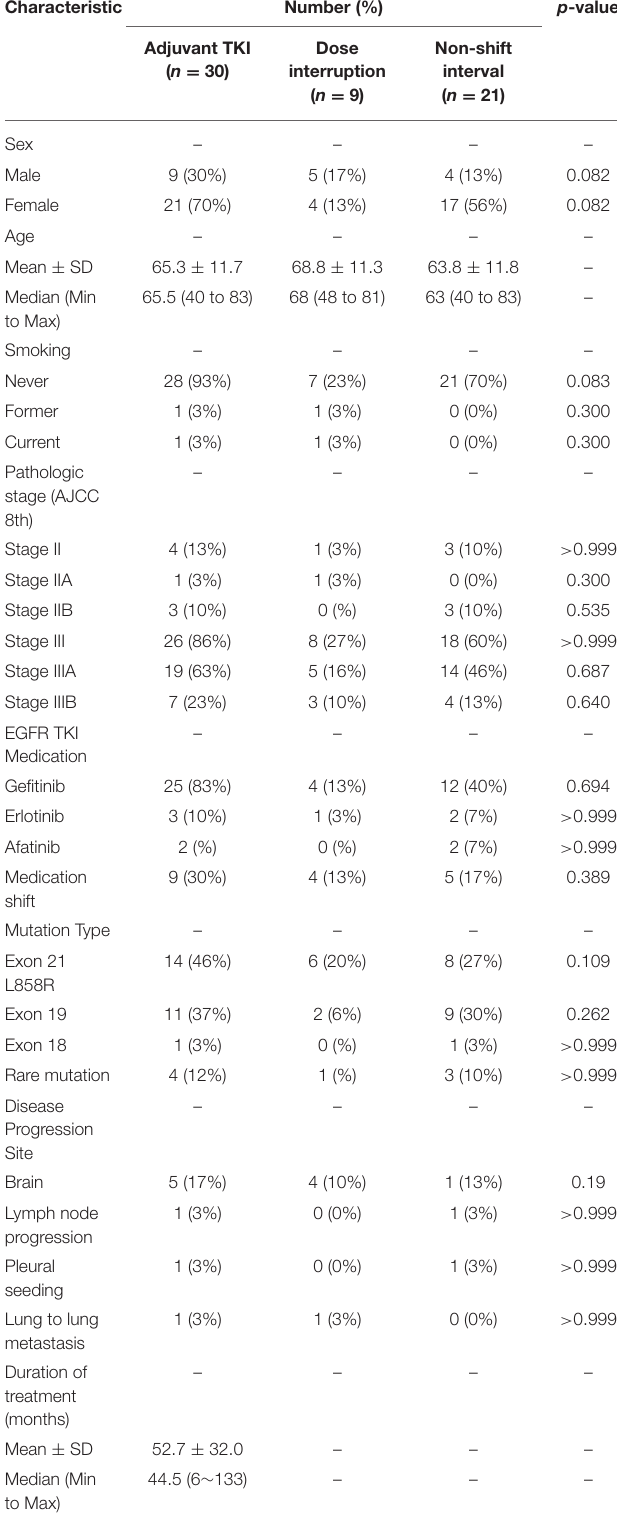
TABLE 1 | Patient